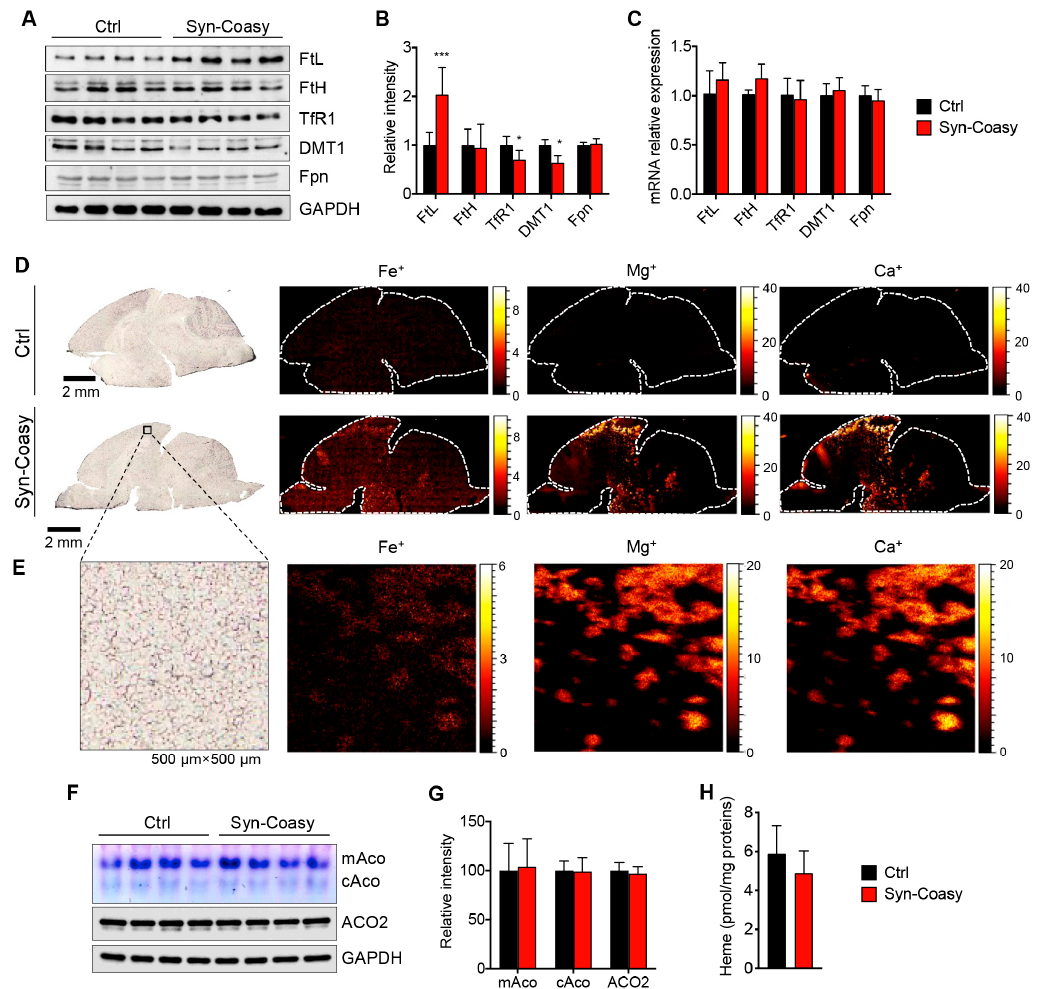
Figure 4. Iron content and homeostasis analysis. ( A ) Immunoblot and ( B ) densitometric quantification of proteins involved in homeostasis in forebrain homogenates from Ctrl ( n ≥ 8) and Syn-Coasy ( n ≥ 8) mice (age P12–P14). GAPDH was used as the loading control. * p < 0.05; *** p < 0.001 (one-way ANOVA). ( C ) Relative expression of the genes encoding the proteins analyzed in ( A ), in the Ctrl ( n = 5) and Syn-Coasy ( n = 5) mice forebrain. No statistically significant differences were observed (one-way ANOVA). ( D ) Elevation of Fe, Ca, and Mg in Syn-Coasy compared to Ctrl by TOF-SIMS imaging. ( E ) The high-resolution imaging of the cortex (500 µ m × 500 µ m) of the Syn-Coasy brain clearly showed colocalization of the Fe + , Ca + , and Mg + . ( F ) Representative in-gel activity of mitochondrial (mAco) and cytosolic (cAco) aconitase, and immunoblot of mitochondrial aconitase (ACO2) in forebrain homogenates from Ctrl ( n = 8) and Syn-Coasy ( n = 8) mice. ( G ) Densitometric quantification of ( F ). GAPDH was used as the loading control. ( H ) Heme quantification by absorbance at 400 nm of the soluble forebrain lysates. For all charts, mean ± SD is